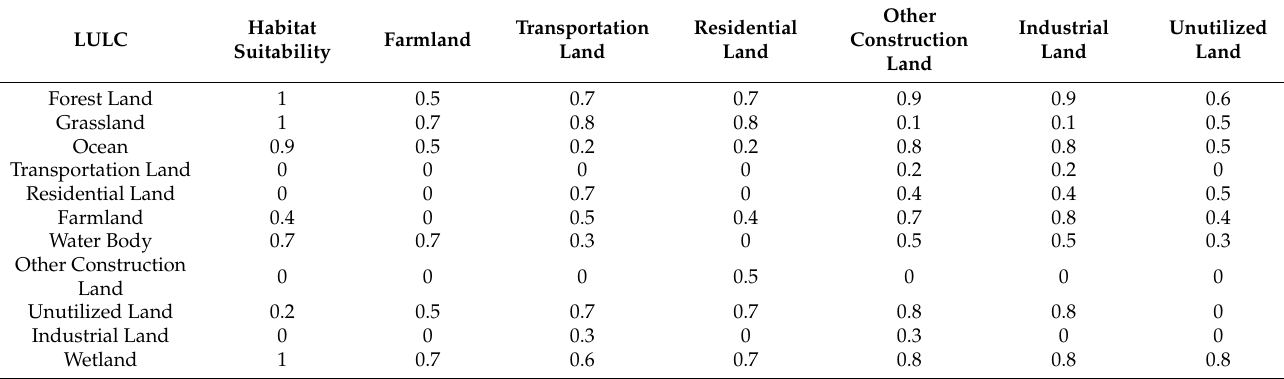
Table 3. The sensitivity of land use type to habitat threat factors. Habitat Transportation LULC Farmland Suitability